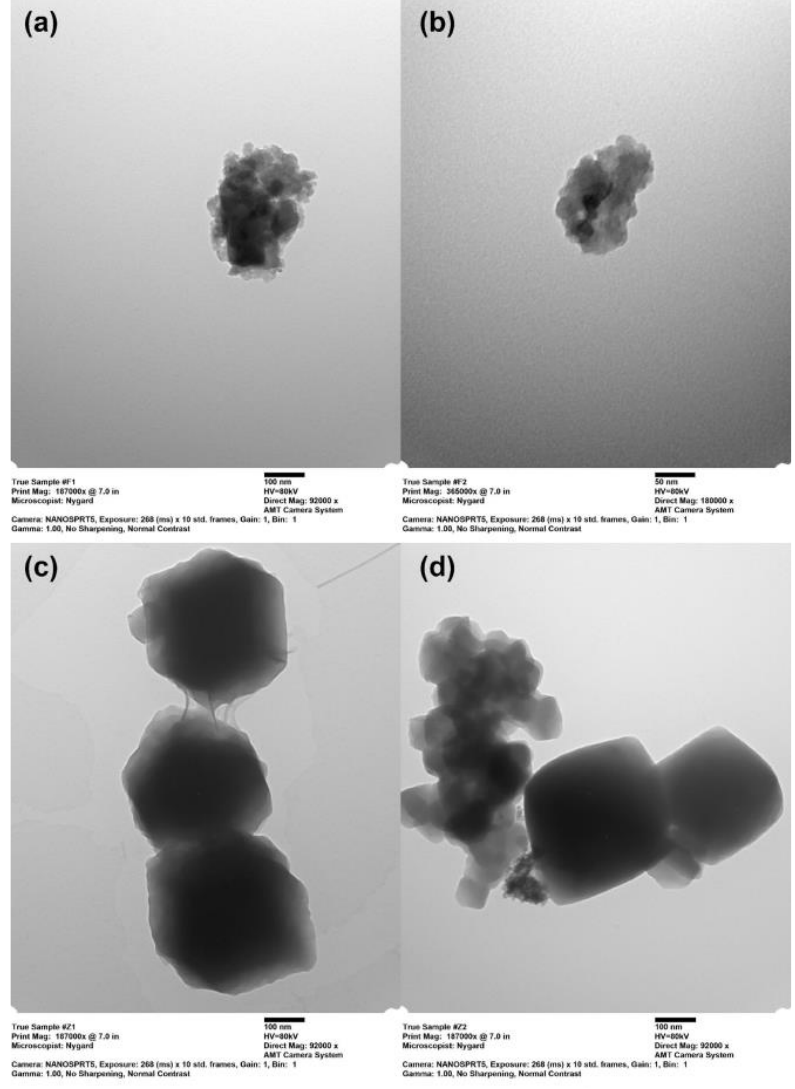
Figure 3. TEM micrographs of ( a ) Fe-BTC; ( b ) Fe-BTC/MO; ( c ) ZIF-8; ( d )